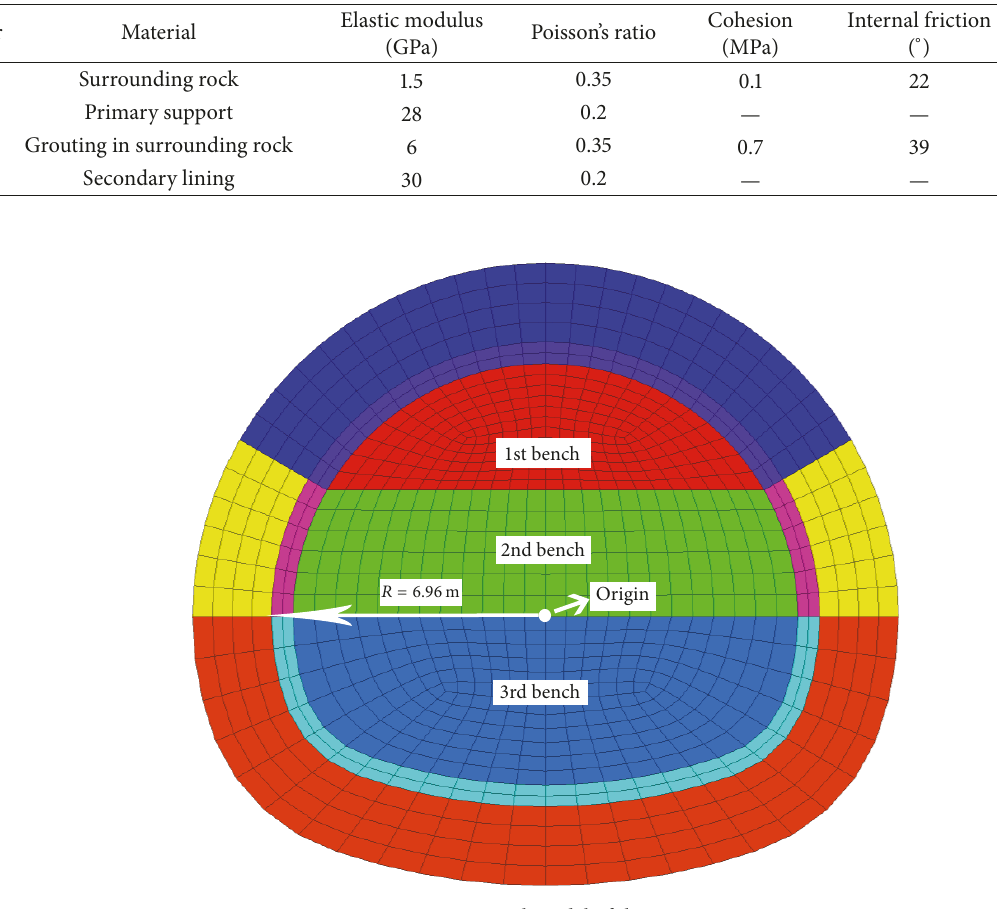
Figure 4: Numerical model of the